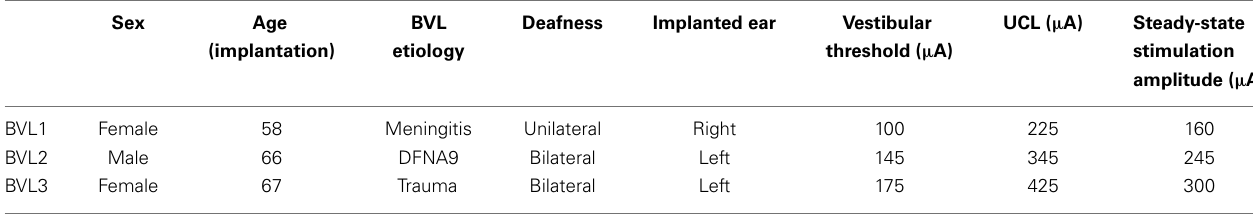
Table 1 | Demographics and stimulation details of the three implanted patients